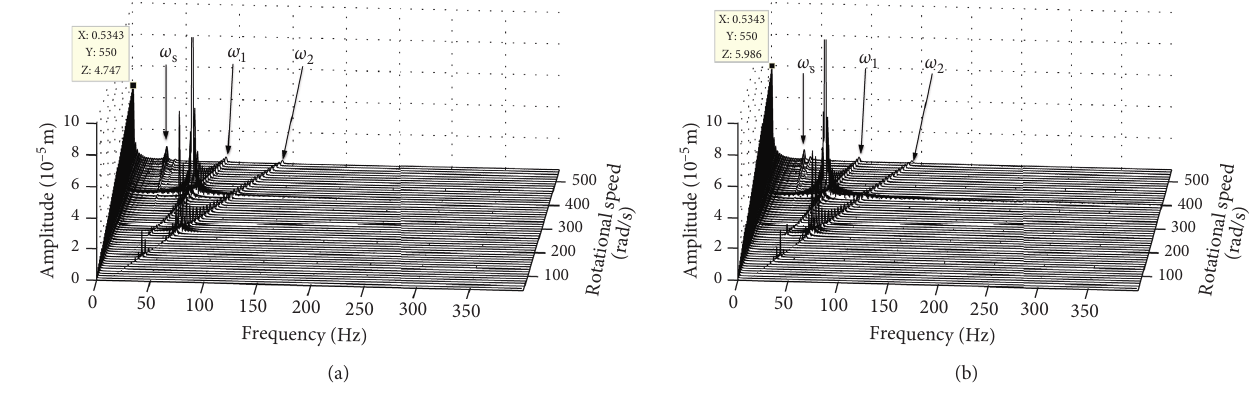
Figure 20: Vertical response of disk 4. (a) λ � 1 . 6. (b) λ � − 1 . 6.